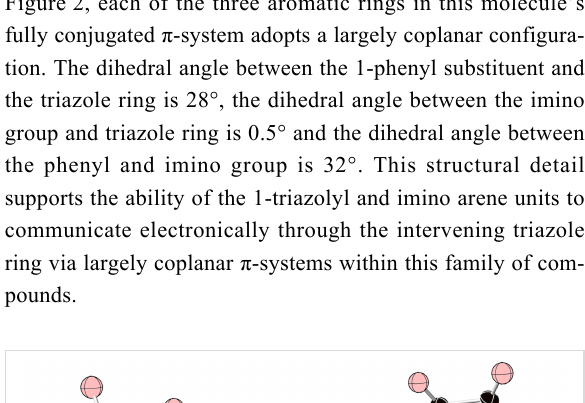
Figure 2: ORTEP structure of 2cc’ . Thermal ellipsoids shown at 25% probability.